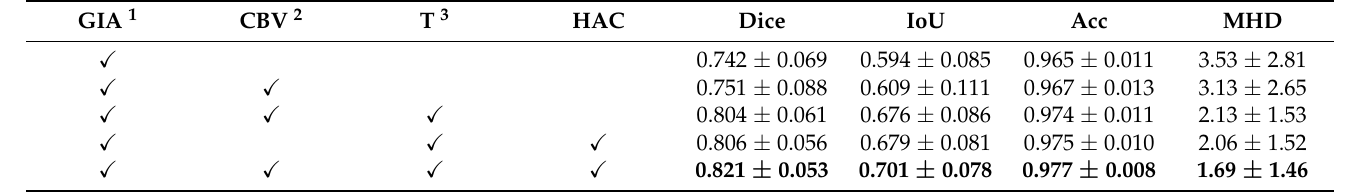
Table 4. Ablation work of the proposed method. The bold number denotes the best result.